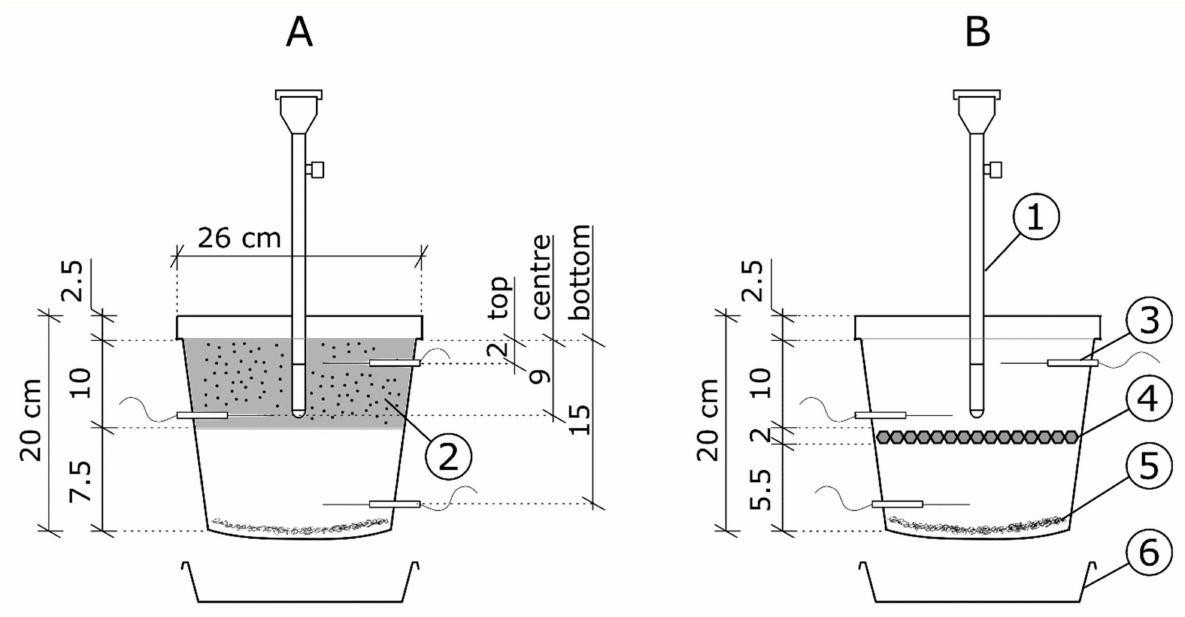
Figure 1. Scheme of sample preparation. ( A ) Pot samples with granular soil amendments (biochar, attapulgite, bentonite, SAP), and ( B ) pot samples with solid state soil amendments (WAG, bioWAG, geotextile). The numbers represent 1— probe for the measurement of soil matric potential, 2—a volume of soil with mixed granular amendment, 3—probe for the measurement of soil moisture, 4—a solid amendment applied as a layer, 5—a drainage mat with geotextile, 6—a tray for effluent. Line marks on the left side of pots ( A , B ) indicate distinct layers. Line marks on the right side of pot A indicate the positioning of the measuring probes in the